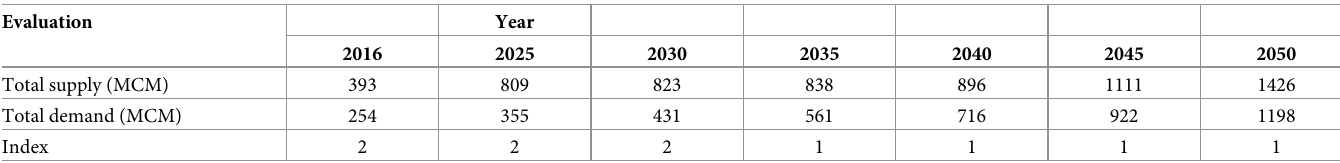
Table 12. Annual total water supply-balance